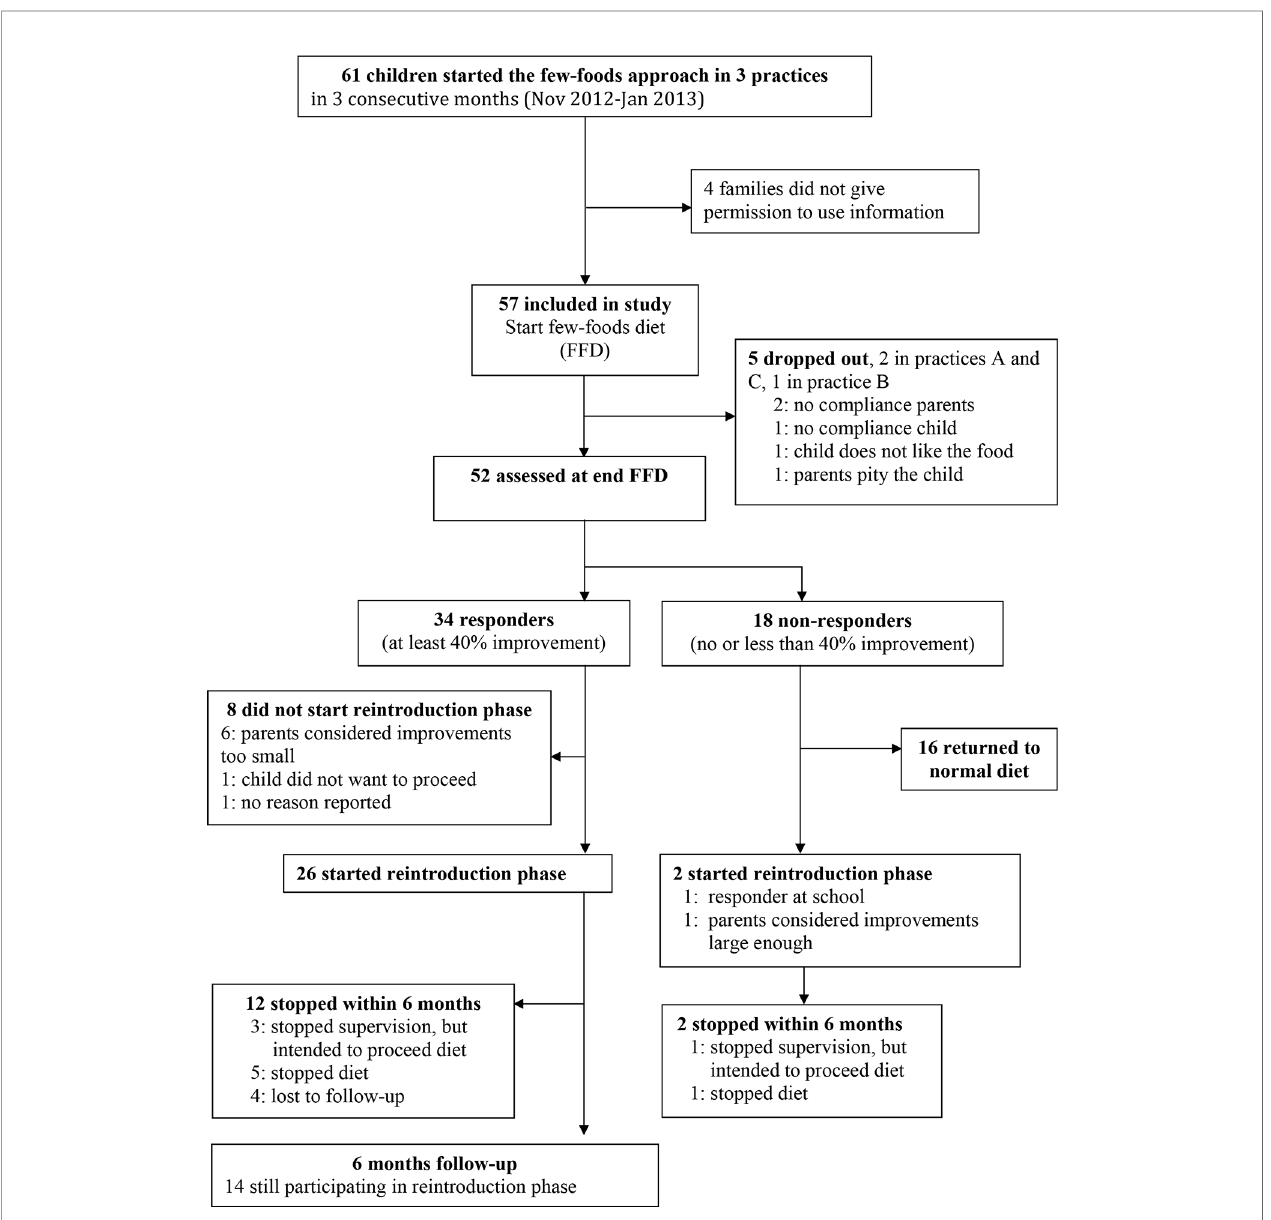
FIGURE 1 | Flow chart study